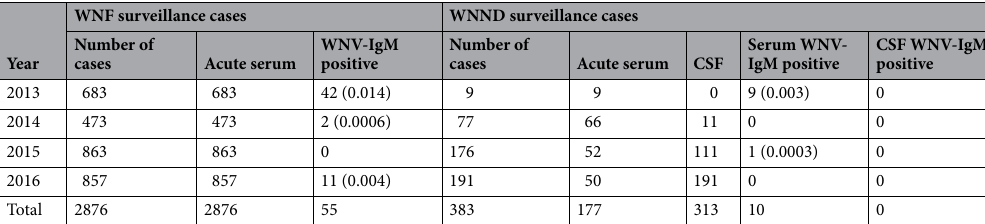
Table 1. Surveillance cases of WNV disease in Kashgar Region,